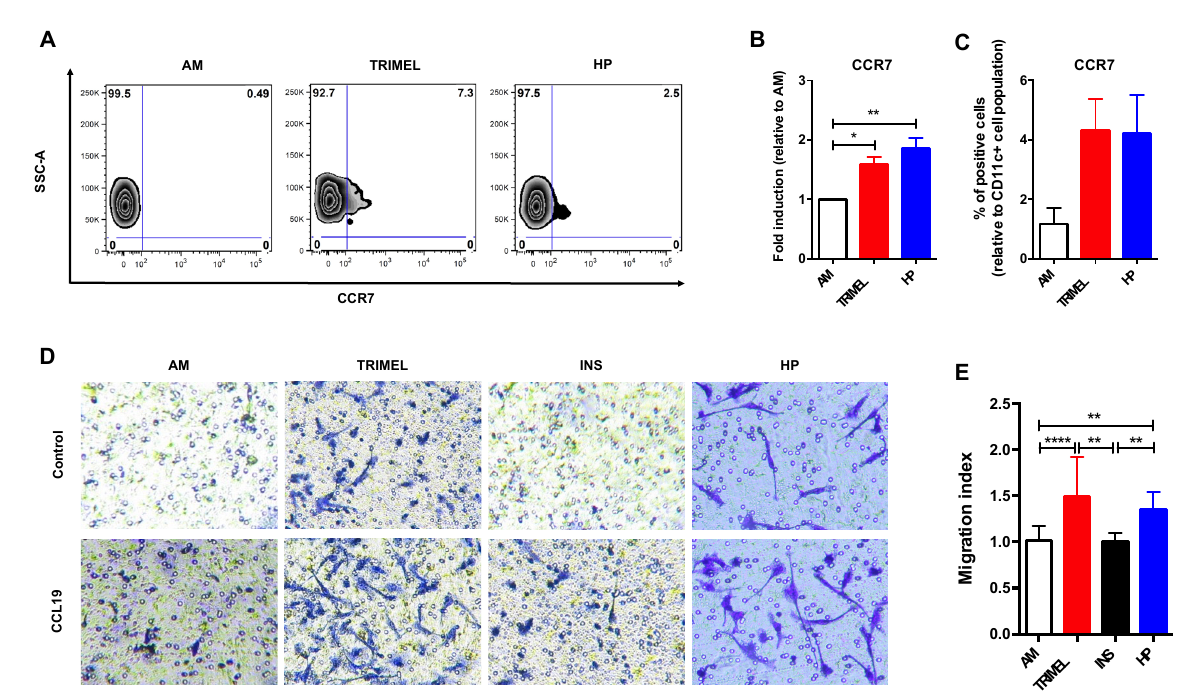
Figure 4. CCR7 expression and in vitro transmigration capability in HS-stimulated primary human iDCs. ( A ) Representative zebra plots showing the percentage of CCR7 positive cells in AM and HP-stimulated cells (1 and 10 ng/mL); ( B ) CCR7 expression in unstimulated cells (AM), TRIMEL-stimulated cells (50 μ g/mL), and HP-stimulated cells (10 ng/mL); ( C ) percentage of CCR7 positive cells in AM, TRIMEL-stimulated cells (50 μ g/mL), and HP-stimulated cells (0,1 and 10 ng/mL); ( D ) representative images from Transwell experiments of different conditions: AM, TRIMEL, INS, and HP in response to the canonical CCR7 ligand, the chemokine CCL19 (10 ng/mL) or AIM-V (negative control); ( E ) quantification of the in vitro transmigration of AM and stimulated cells with TRIMEL (50 μ g/mL), Insulin (10 ng/mL), and HP (10 ng/mL). Data are expressed as a migration index, which is the ratio between the number of migrated cells towards CCL19 and the number of migrated cells towards the medium alone for each cell condition studied. * p < 0.05; ** p < 0.01; **** p < 0.0001 .